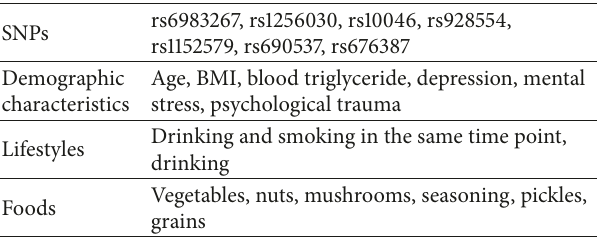
Table 1: Results of biological classification.